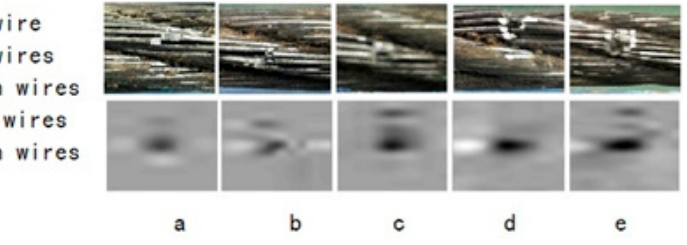
Figure 8. Photos ( above ) and local MFL image ( below ).